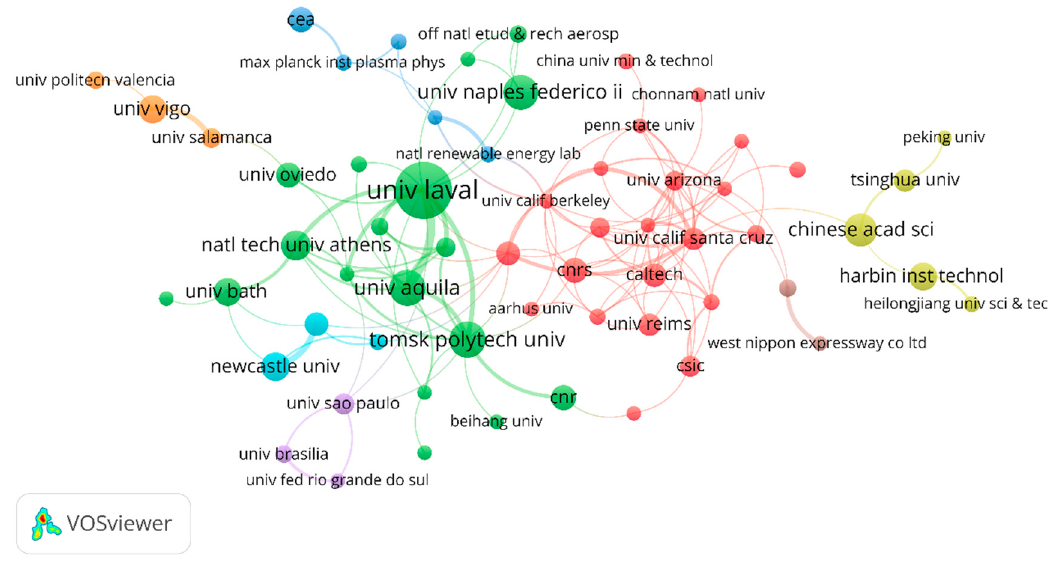
Figure 4. Organizations coauthoring knowledge map.